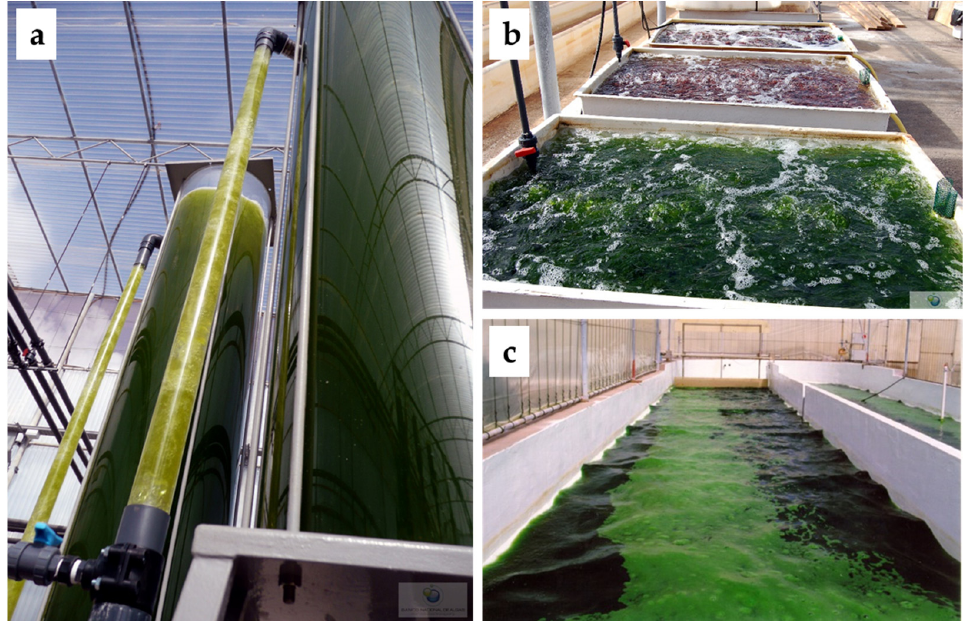
Figure 2. Examples of cyanobacteria cultivation systems: ( a ) photobioreactor; ( b ) tanks; ( c ) raceway at the Banco Español de Algas (BEA) experimental plant of microalgae (Courtesy: